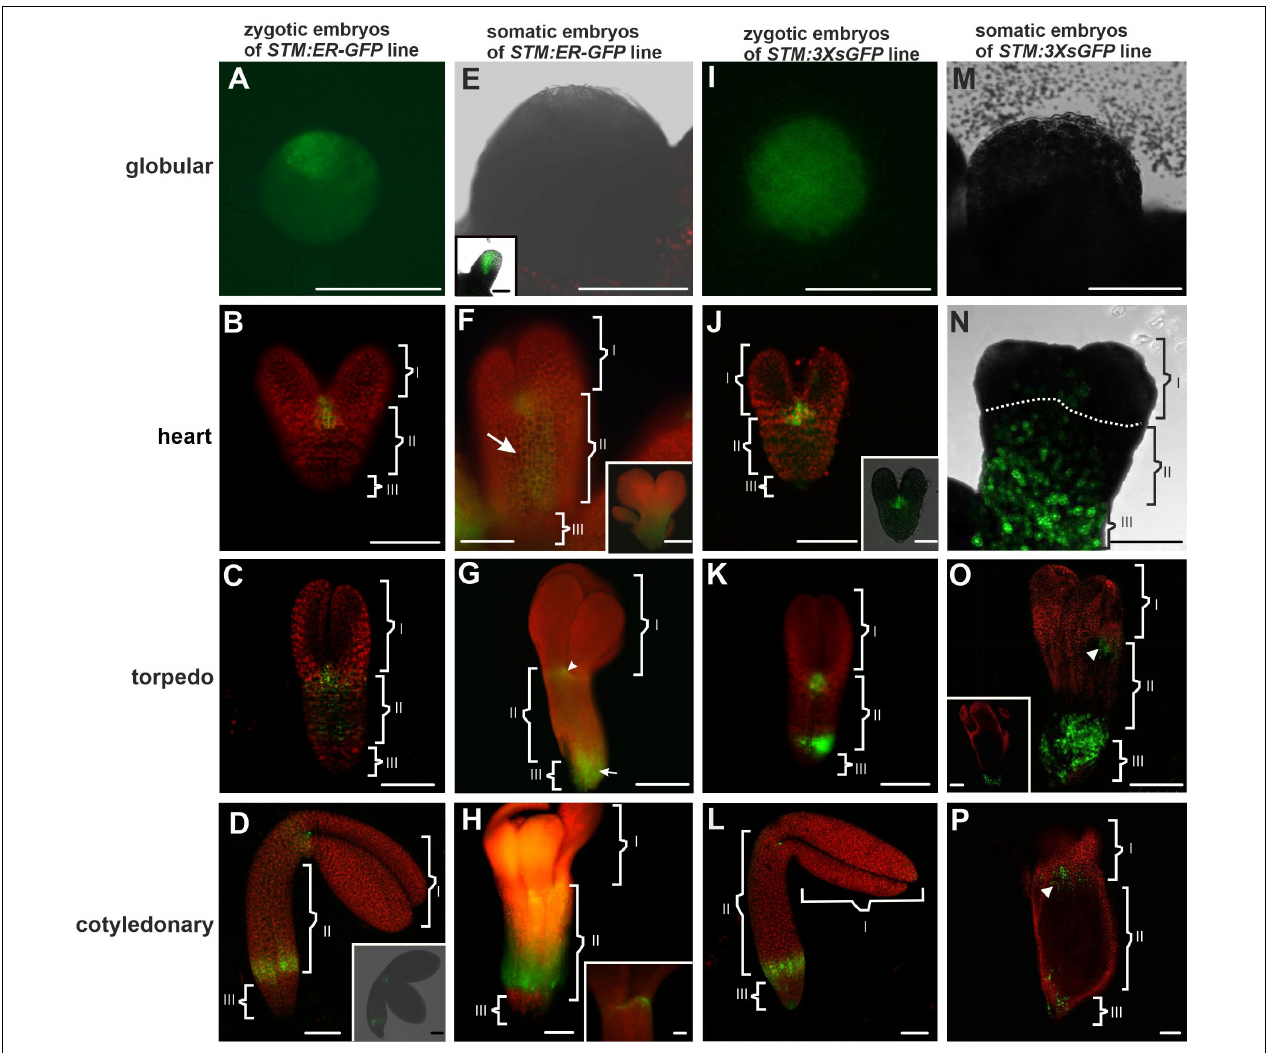
FIGURE 1 | STM:ER-GFP promoter activity and localization of the 3XsGFP in the ZEs and SEs. Promoter activity in the (A) globular; (B) heart, (C) torpedo, and (D) cotyledonary stages of ZEs. (D inset) The optical section of the ZE (from CLSM). (E) Globular SE without any visible promoter activity. (E inset) Advanced stage of the globular SE with a promoter activity. (F and F inset) Heart and (G) torpedo stages of the SE. (H) Cotyledonary stage of the SE. (H inset) The SAM in an embryo in the cotyledonary stage. (I) Globular and (J) heart stages of the ZEs with the fluorescence of the 3XsGFP. (J inset) Optical section through the heart embryo. (K) Torpedo and (L) cotyledonary stages of the ZE – green fluorescence indicates the presence of the 3XsGFP. (M) In the globular SE, the 3XsGFP was not detected. (N ) Heart and (O) torpedo stages of the SE. (O inset) The optical section through the basal part of the SE embryo in the torpedo stage. (P) Cotyledonary stage of the SE – green fluorescence indicates the presence of the 3XsGFP [arrowheads on (O,P) indicate the area with the GFP in the identified SAM area]. The embryo was divided into three parts I – apical, II – central and III – basal. A,F,F inset,G,H,H inset – Images from the epifluorescence microscope; B–D,D inset,J inset,K–O,O inset,P – images from CLSM. Scale bars; A,C,D,D inset E,E inset,F,F inset,G–O,O inset , P = 100 µ m; B,J,J inset,H inset = 50 µ m.